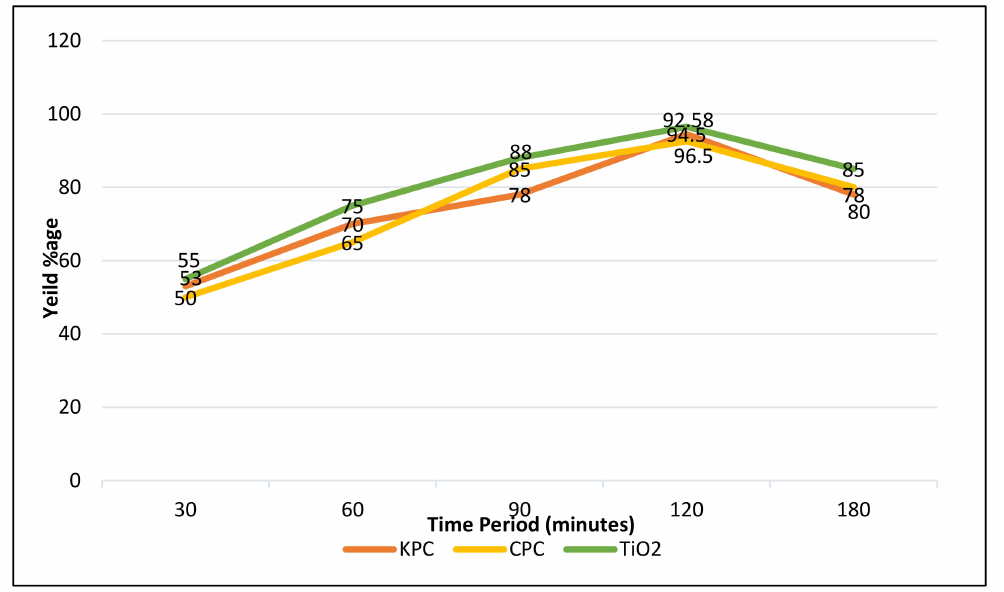
Figure 27. Time period effect on transesterification, while other variables were kept constant (temper- ature, catalyst amount, oil-to-methanol